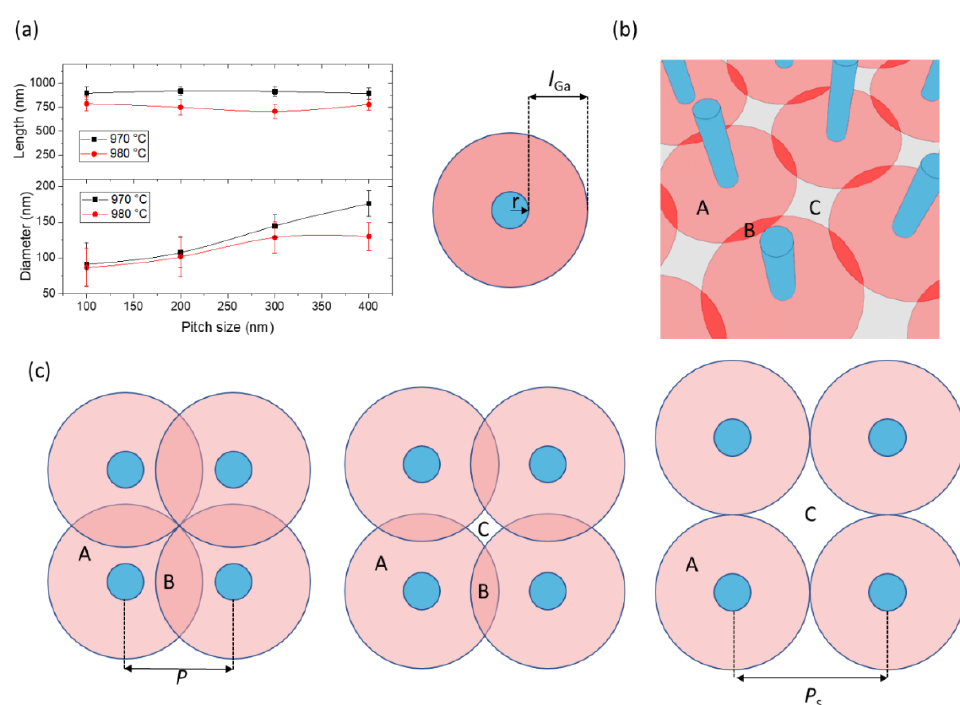
Figure 6. ( a ) Average diameters and lengths of the NRs grown at T G = 970 ◦ C and T G = 980 ◦ C on patterns with different pitch; ( b ) Schematic of the GaN NR collection area model; and ( c ) Schematic of the pitch effect on the collection area. A, B, and C indicate the various collection zones that determine whether an incoming Ga adatom is incorporated or desorbed.